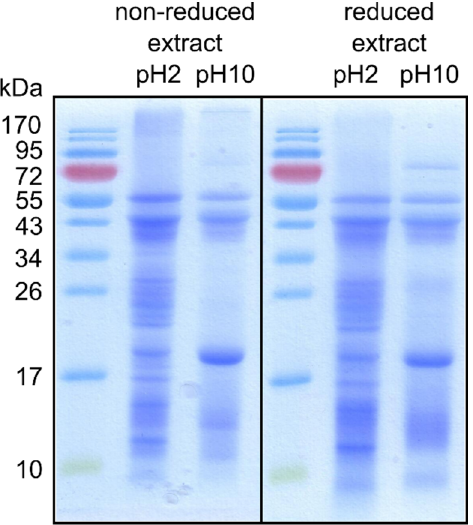
Figure 1. SDS-PAGE analysis of the mealworm protein extracts. The proteins were extracted from